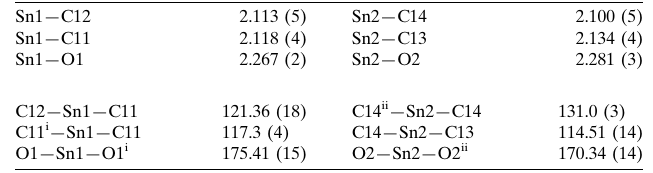
Selected geometric parameters (A˚ , (cid:3)